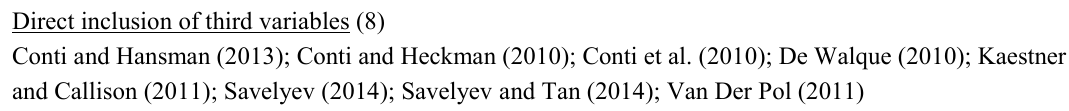
Classification and inventory of studies,